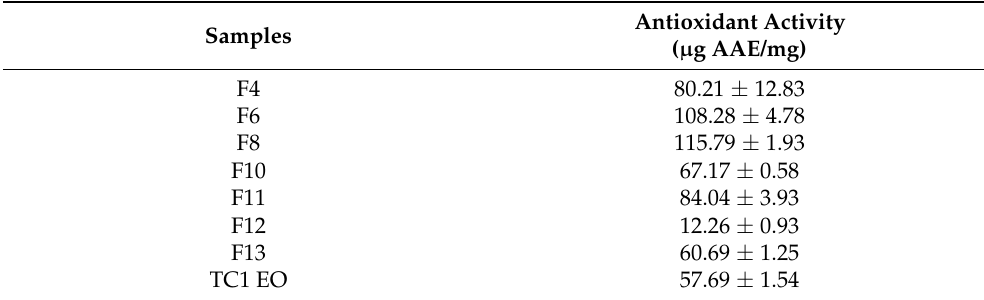
Table 5. Antioxidant activity of essential oil of Thymus capitatus (TC1) encapsulated in different